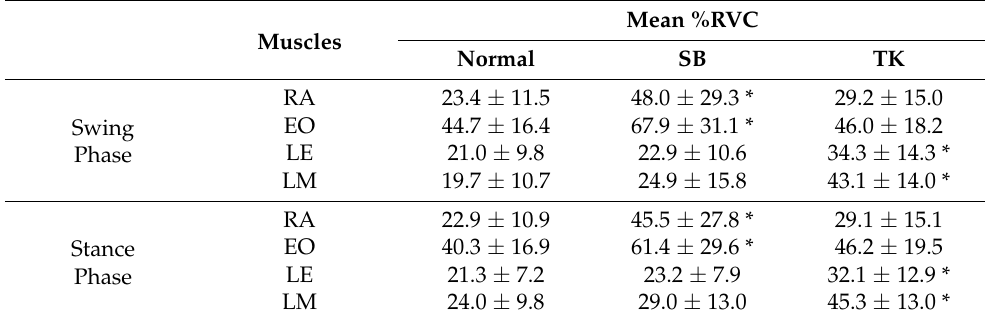
Table 3. The percentage reference voluntary contraction (RVC) of four trunk muscles during the swing and stance phases of gait.